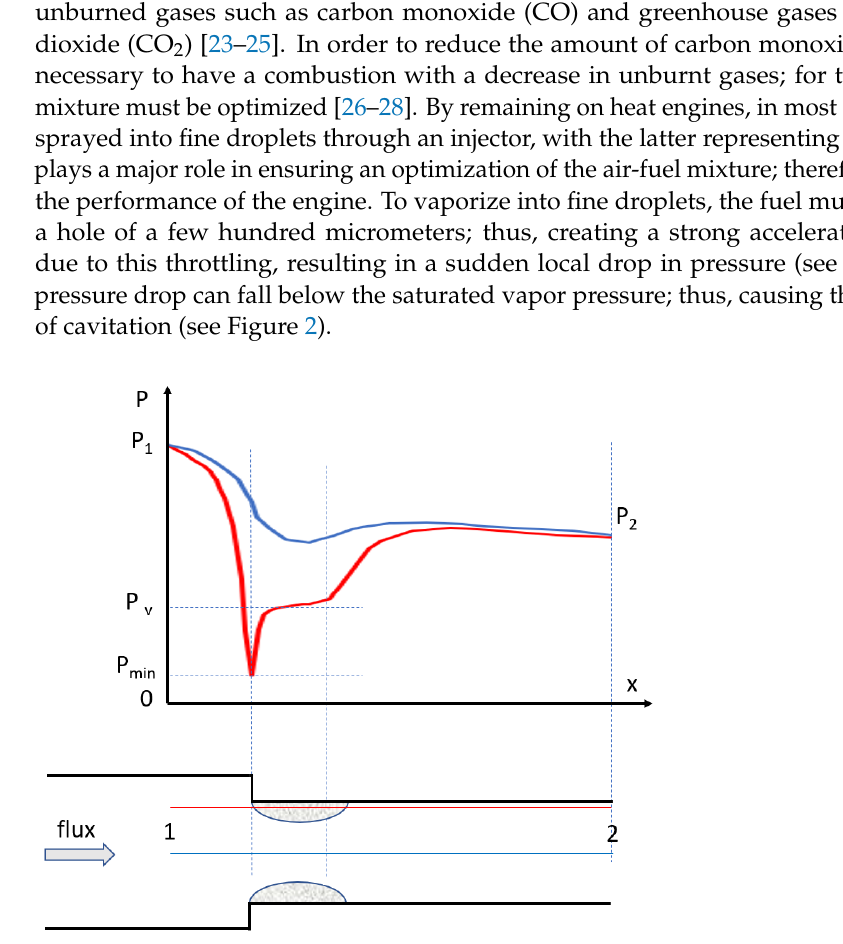
Figure 1. Schematic representation of the pressure level inside nozzle in the middle (blue line) and near the wall region (red line).